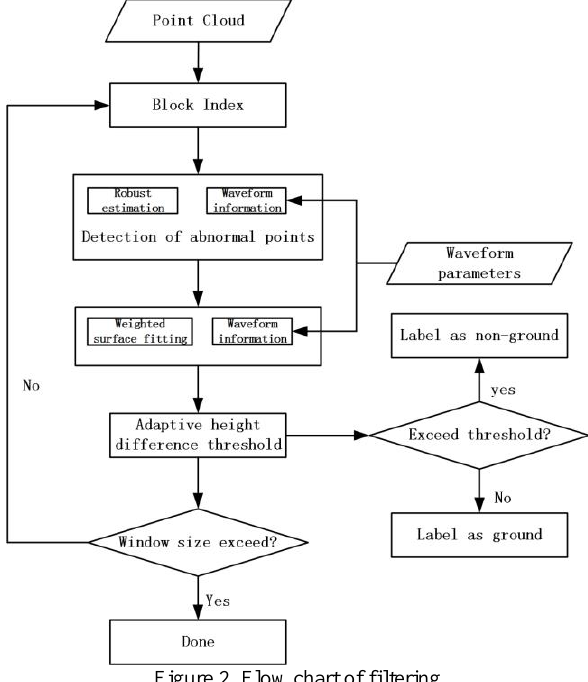
Figure 2. Flow chart of